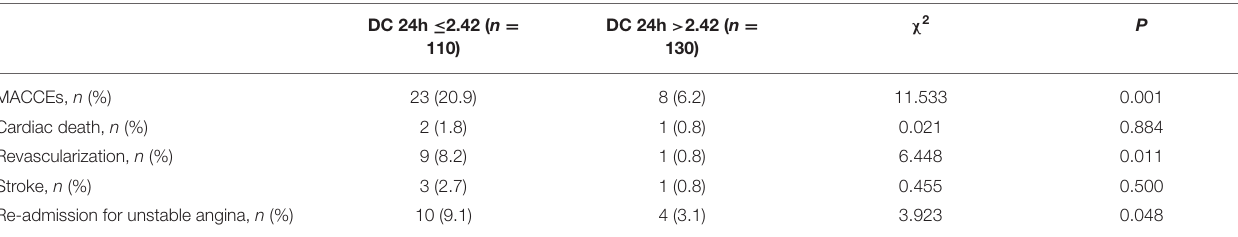
TABLE 2 | Incidence of adverse outcomes according to 24-hour deceleration